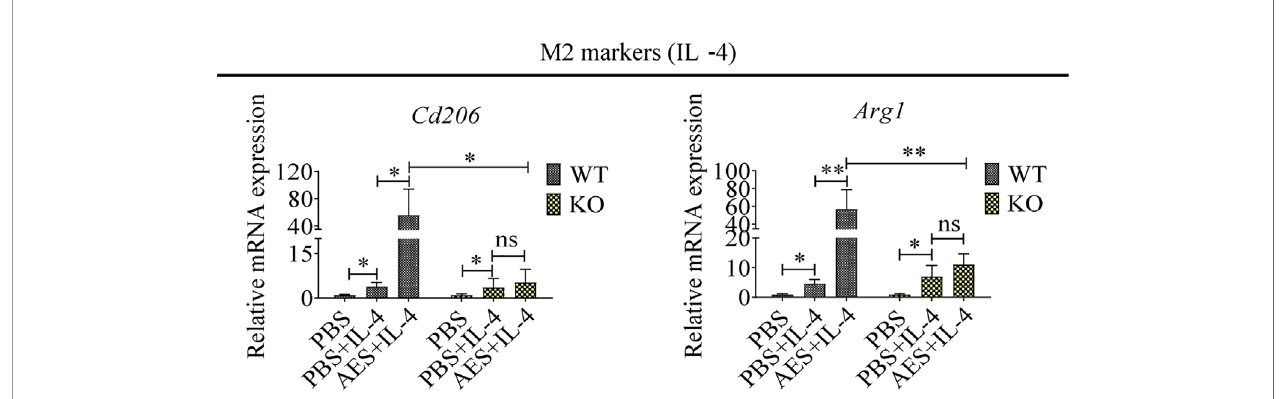
FIGURE 5 | PD-1 de fi ciency reduced AED-induced M2 macrophage polarization, Peritoneal macrophages were isolated from wild type or PD-1 knockout mice and treated with AES. IL-4 was subsequently added to induce M2 polarization. Markers of M2 macrophages ( Cd206 and Arg1 ) were analyzed by qRT-PCR. Experiments were repeated in triplicate. * P < 0.05, ** P < 0.01; ns = not signi fi